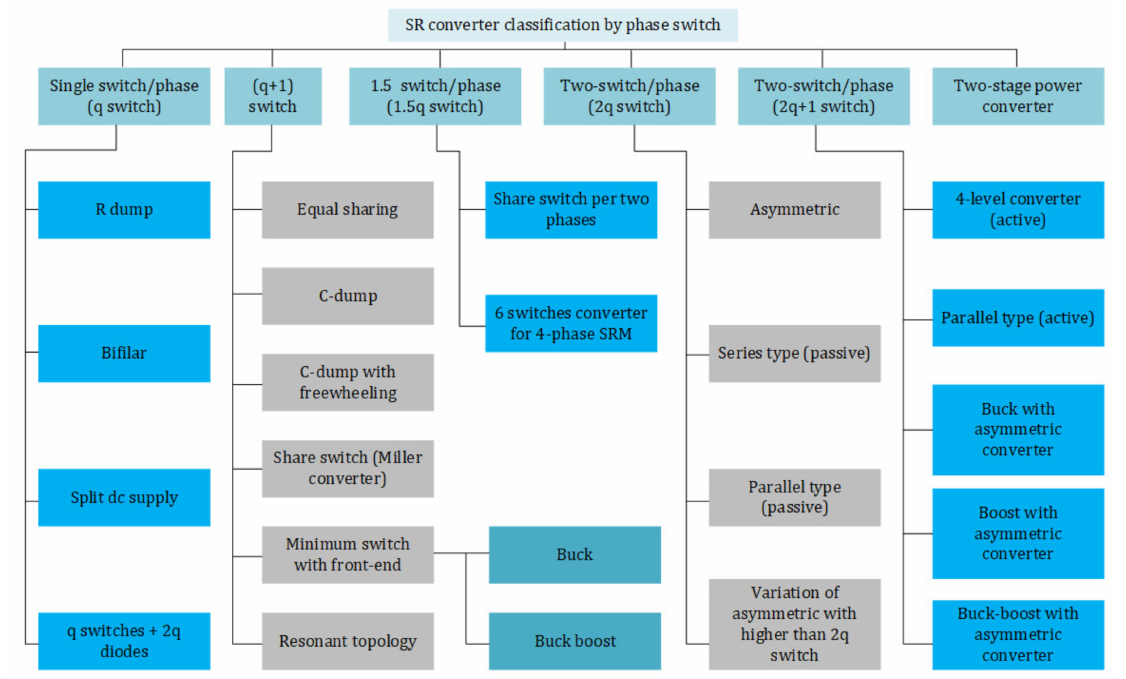
Figure 11. SR converter configuration by phase switch edited from